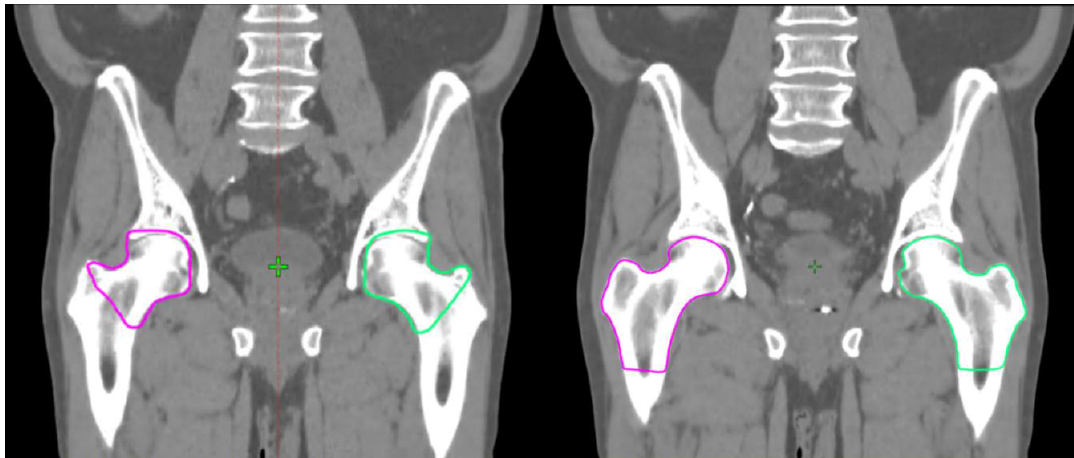
Figure 3. On the left , the femoral heads drawn by the automated segmentation tool (AST). On the right , the femoral heads drawn by an oncologist at Clinic 6.